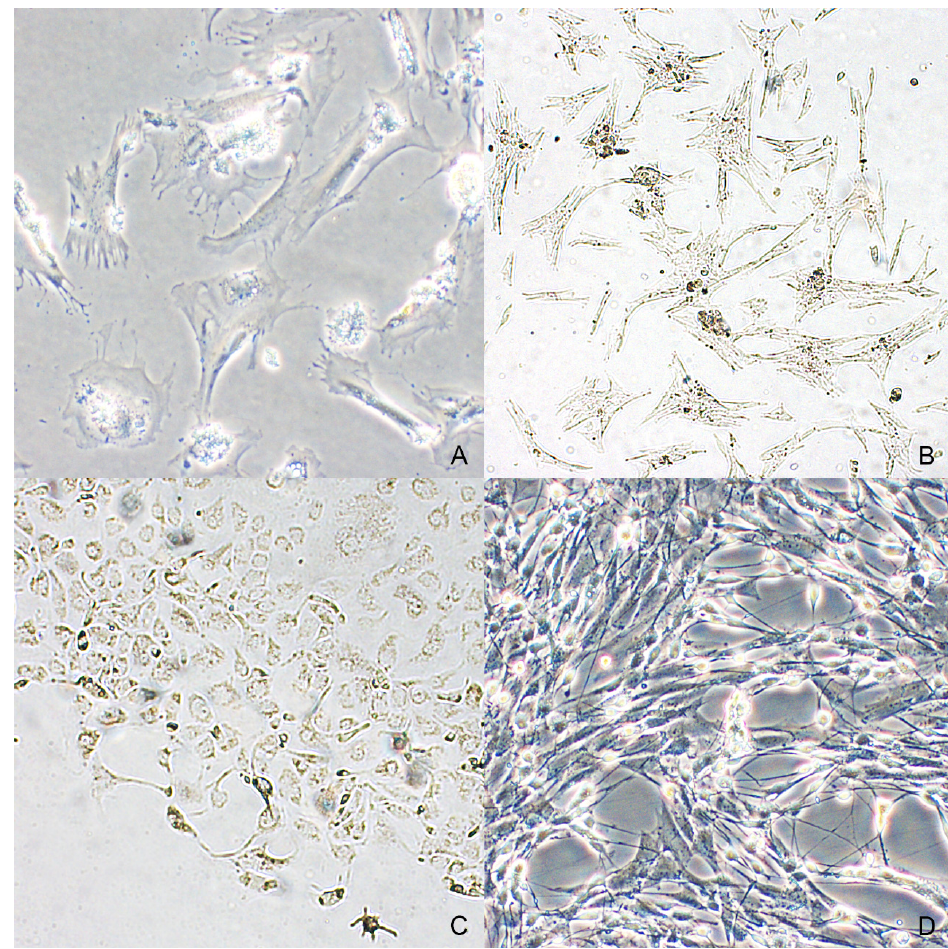
Figure 4 . Dendritic to spindle shape was observed in neoplastic melanocytes from an oral melanoma (case n. 2) both in cultures treated with enzymatic digestion ( A ) and in the ones provided by spontaneous migration ( B ). ( C ) Most neoplastic melanocytes from cutaneous melanoma were characterized by a polygonal shape and abundant intracytoplasmic melanin (case n. 4). ( D ) Neoplastic melanocytes from the nodal metastasis of the case n. 3 (phase-contrast microscopy).